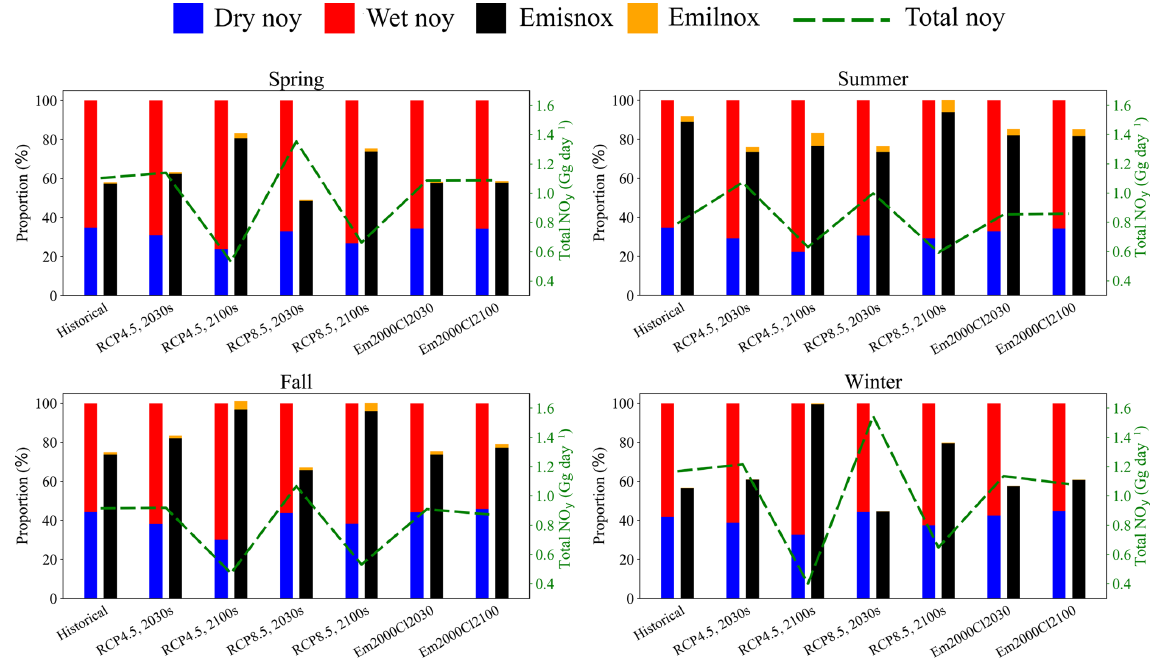
Figure 8. Same as Fig. 7 except for the East China